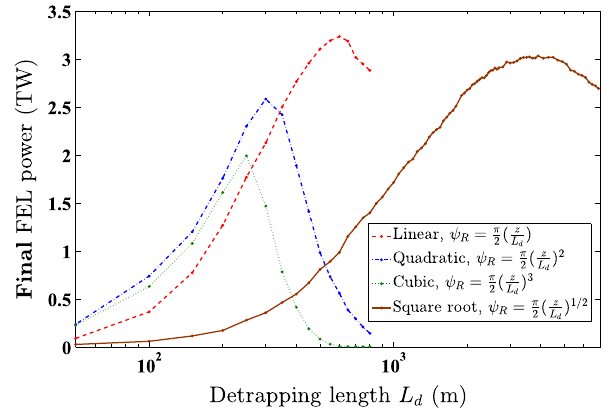
FIG. 5. Comparison of the final FEL powers resulting from different choices of the increasing function ψ ∝ z ), quadratic ( ψ ( ψ R ∝ z 1 = 2 ). The final FEL power refers to the power at the end of ( ψ R the undulator line ( z ¼ L of the detrapping length L logarithmic